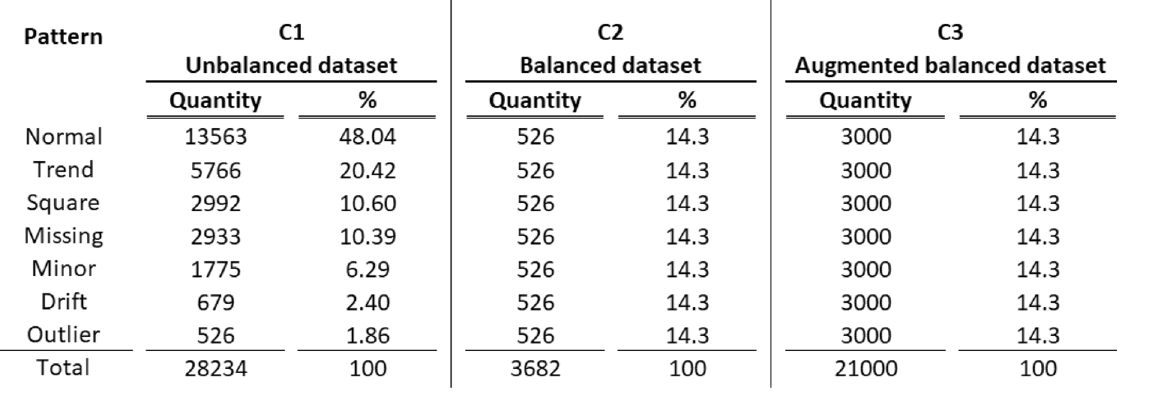
Table 2 Quantity and percentage for each data class of the selected benchmark